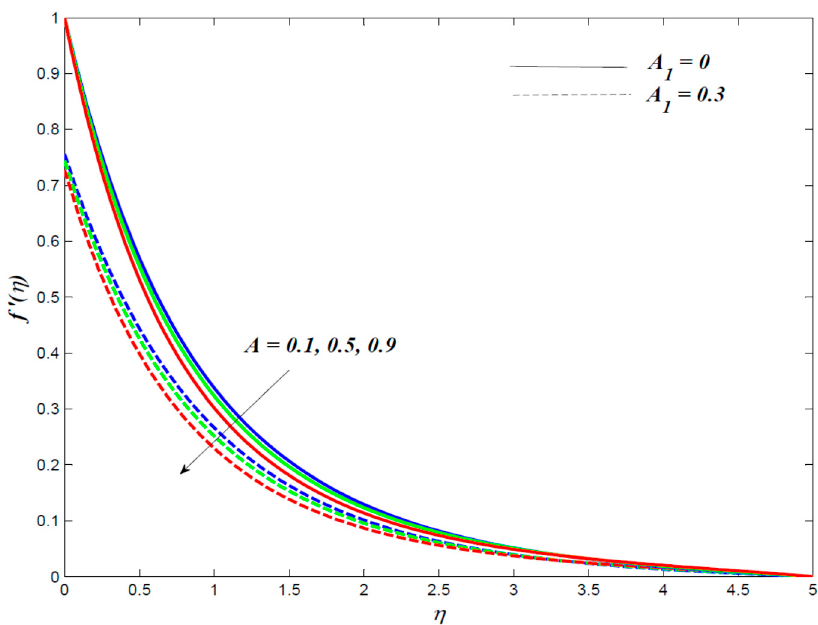
Mathematics 2020 , 8 , x FOR PEER REVIEW Figure 6. Velocity profile due to variation in unsteadiness parameter. Figure 6. Velocity profile due to variation in unsteadiness parameter.